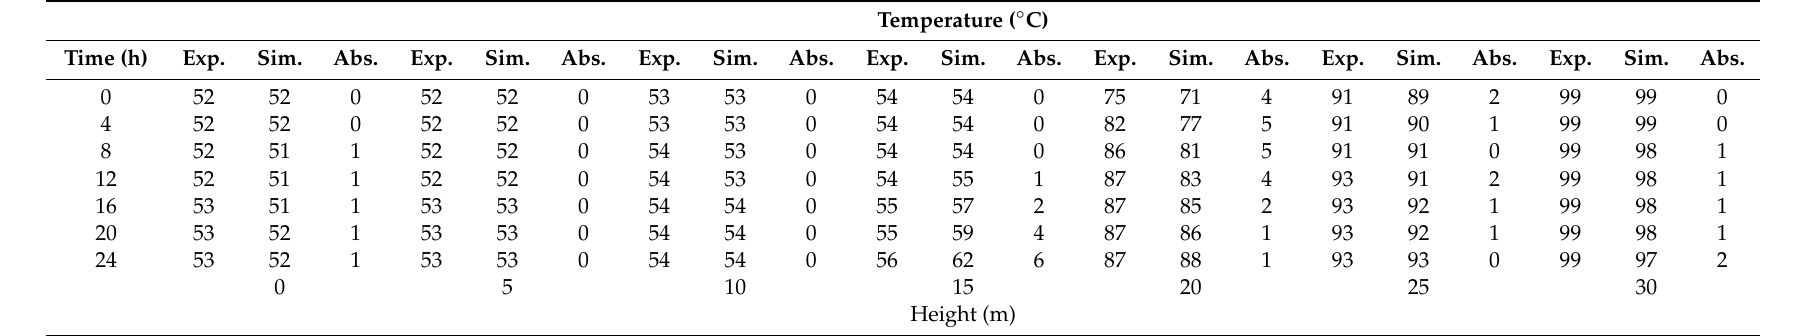
Table 4. Comparative table of experimental and simulated daily temperature evolution inside the TES